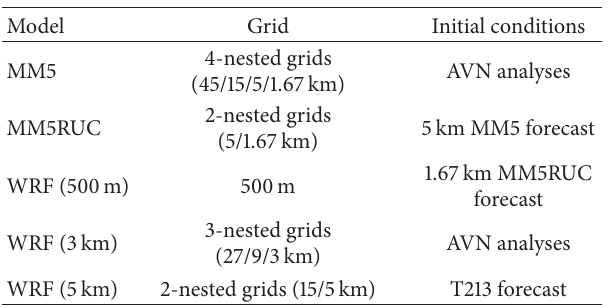
Table 1: Overview of dynamical models.